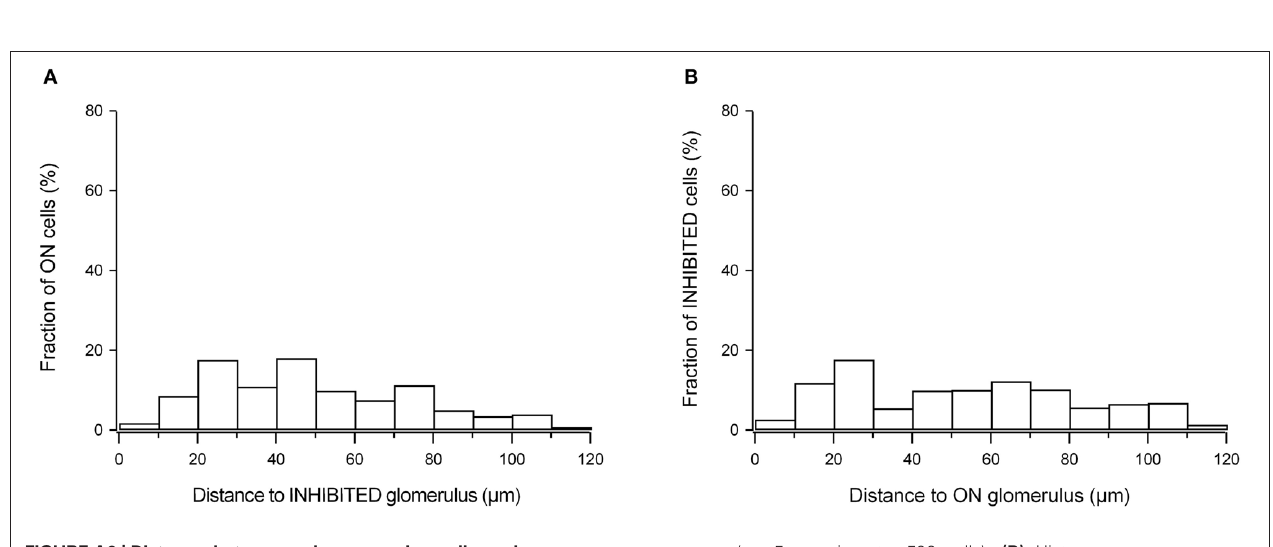
FIGURE A6 | Distance between odor-responsive cells and glomeruli with different odorant specificity. (A) Histogram summarizing the distance of all odor-activated ON neurons to the three-dimensionally nearest glomerulus with INHIBITED